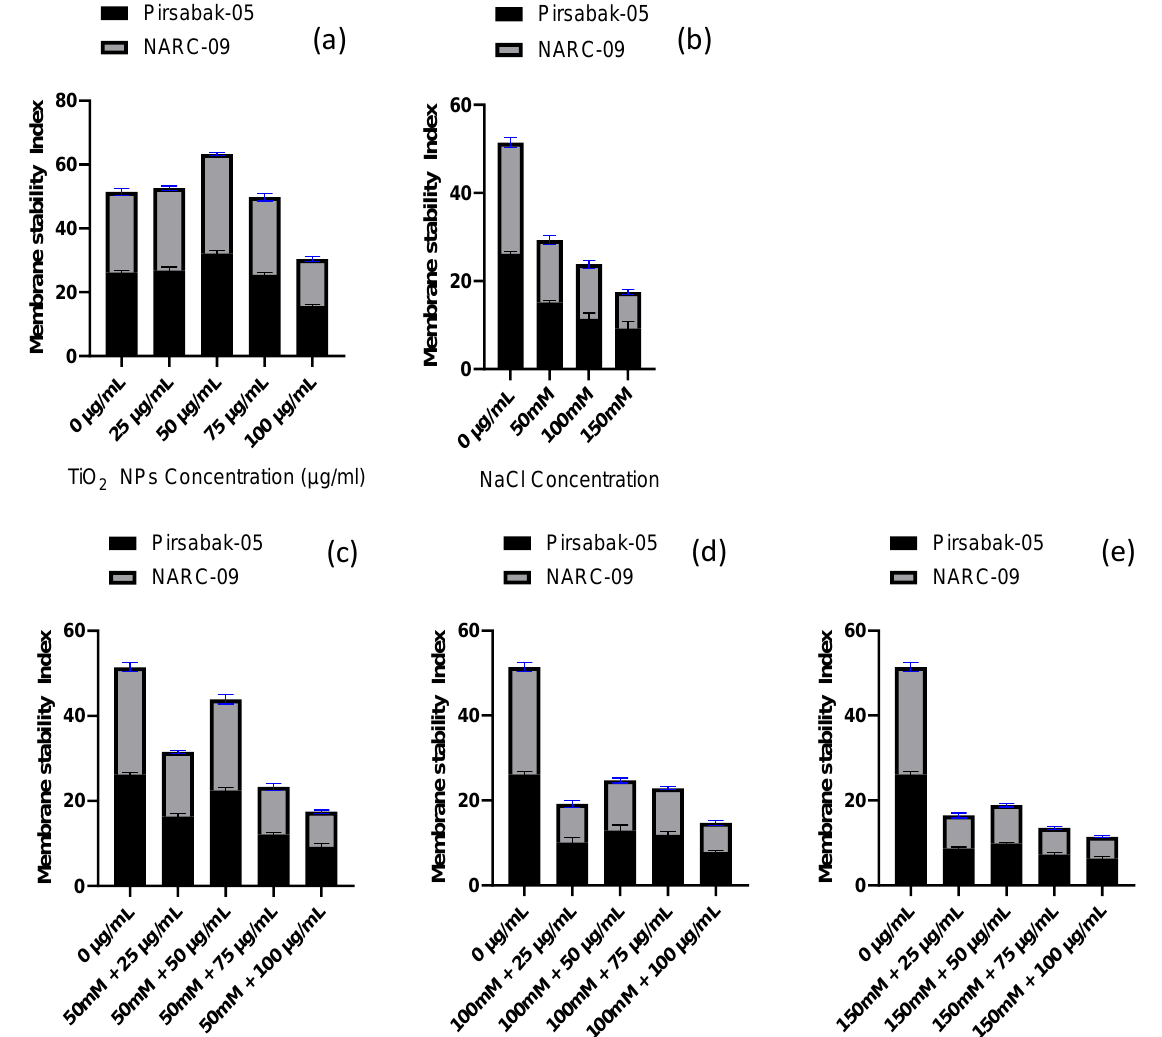
Figure 2. Effects of biogenic TiO 2 NPs on the membrane stability index of selected wheat varieties under salinity stress conditions; ( a ) Effect of different concentrations of biogenic TiO 2 NPs on wheat varieties, ( b ) Effect of different concentrations of NaCl on wheat varieties, ( c – e ) Effect of different concentrations of TiO 2 NPs under varied concentrations (i.e., 50 mM, 100 mM, and 150 mM of NaCl). The data are represented in the form of means, while p was kept at p ≤ 0.05.